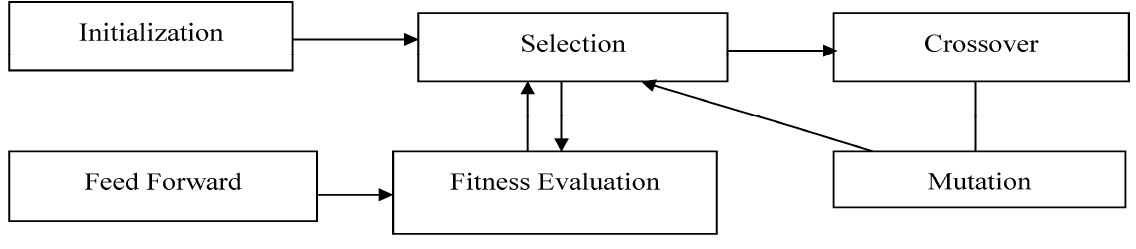
Figure 3. Working of Evolutionary Neural